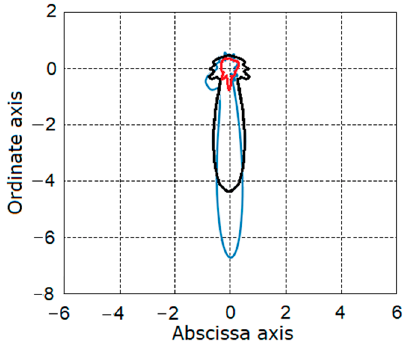
Figure 17. The time changes of the variance estimators on the plane.